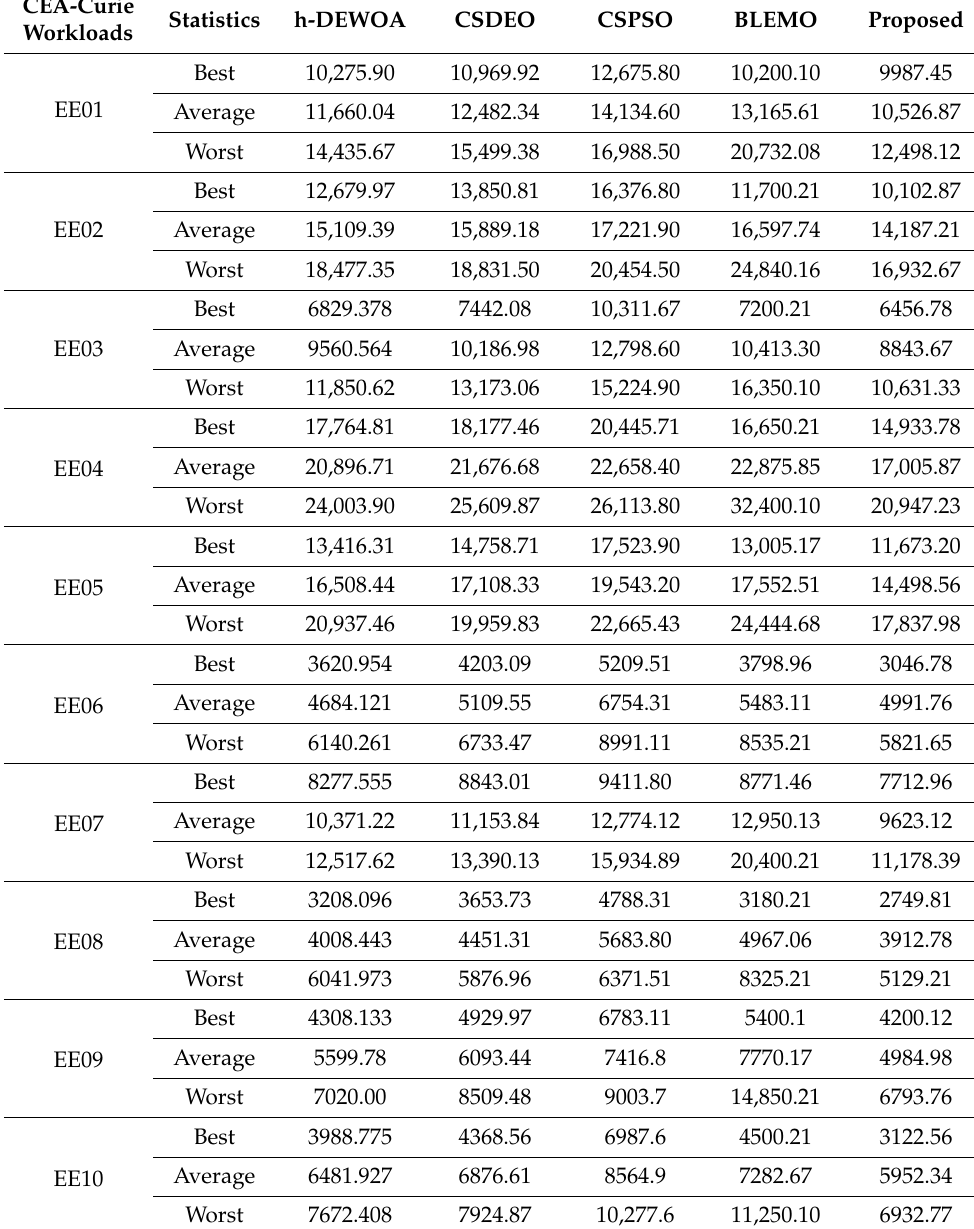
Table 4. Makespan results for CEA-curie